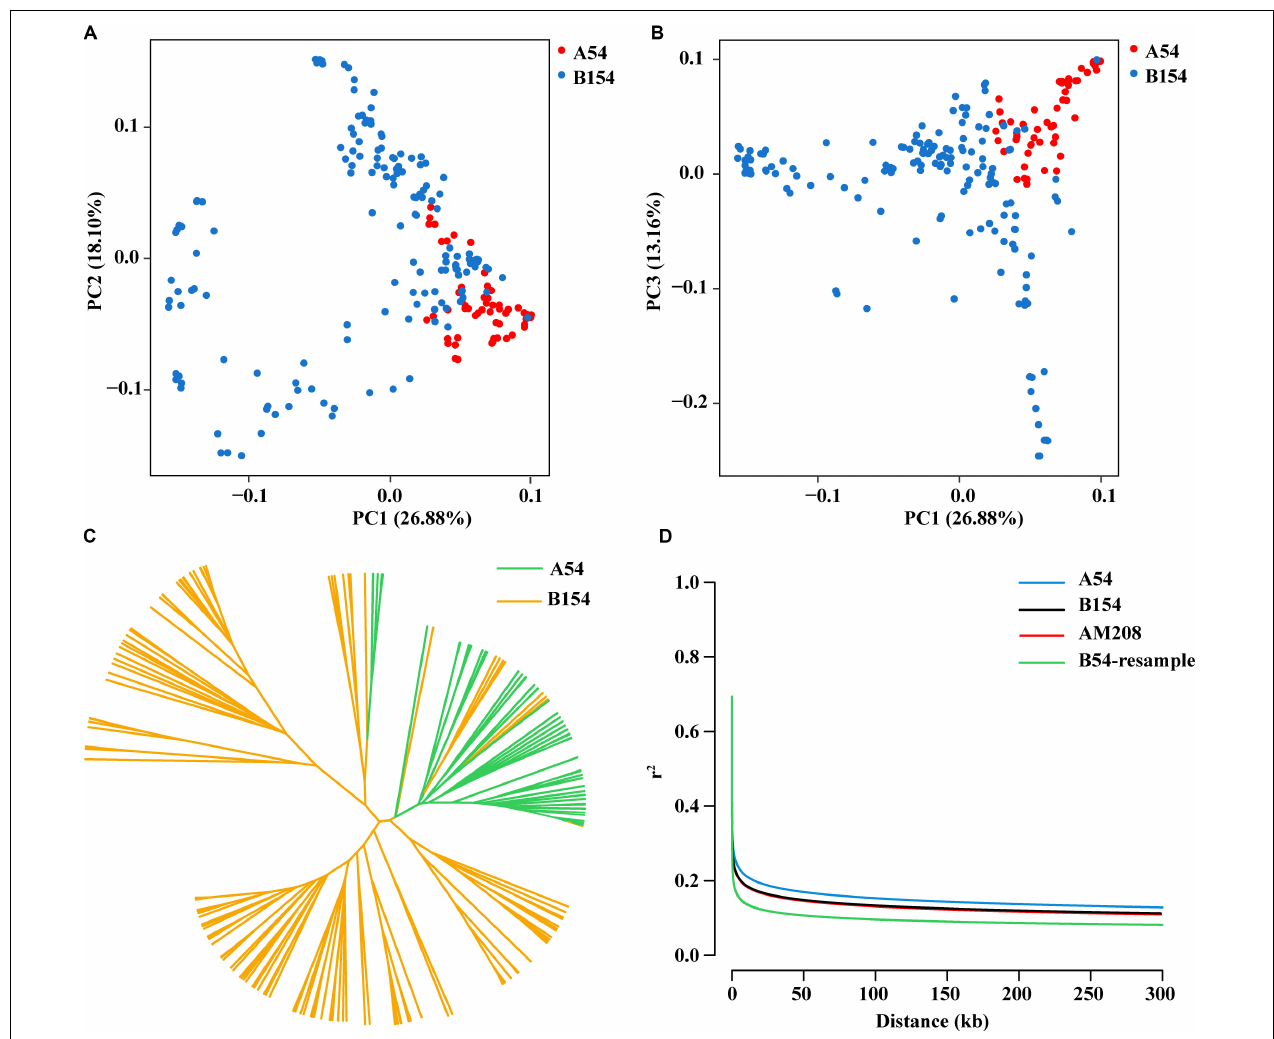
FIGURE 1 | Population characteristic of AM208. (A) Scatter plot for PC1 and PC2. (B) Scatter plot for PC1 and PC3. (C) Phylogenetic tree of AM208 was constructed with 32,306 SNPs. (D) Linkage disequilibrium (LD) decay of AM208, A54, and